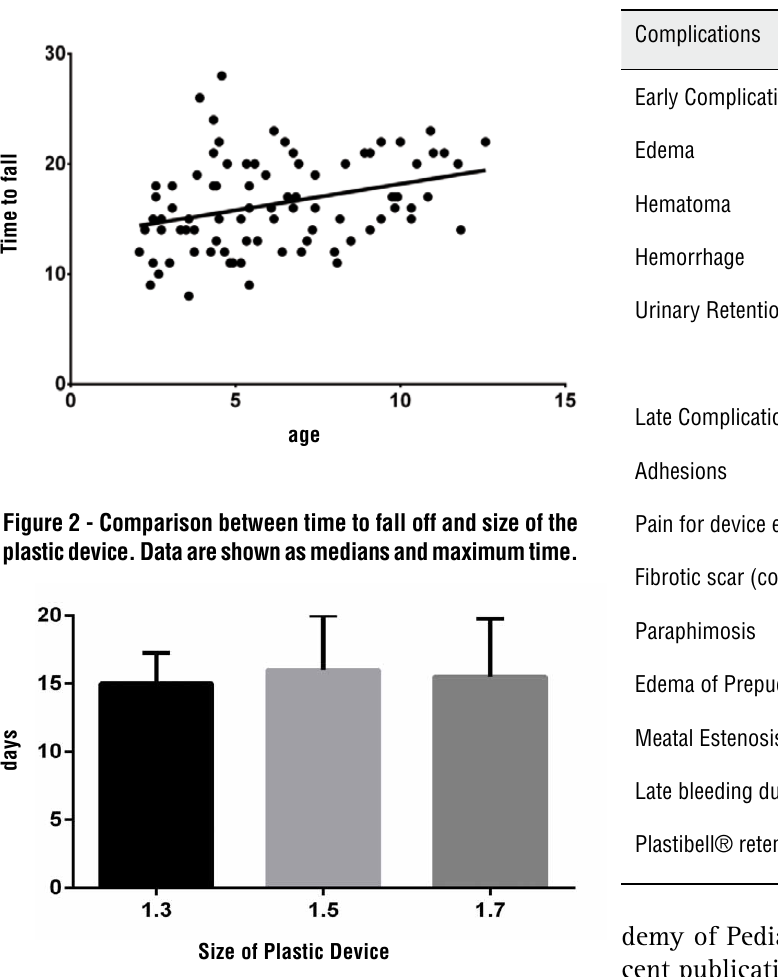
Figure 1 - Correlation between time for the plastic device to fall off and age of the child.